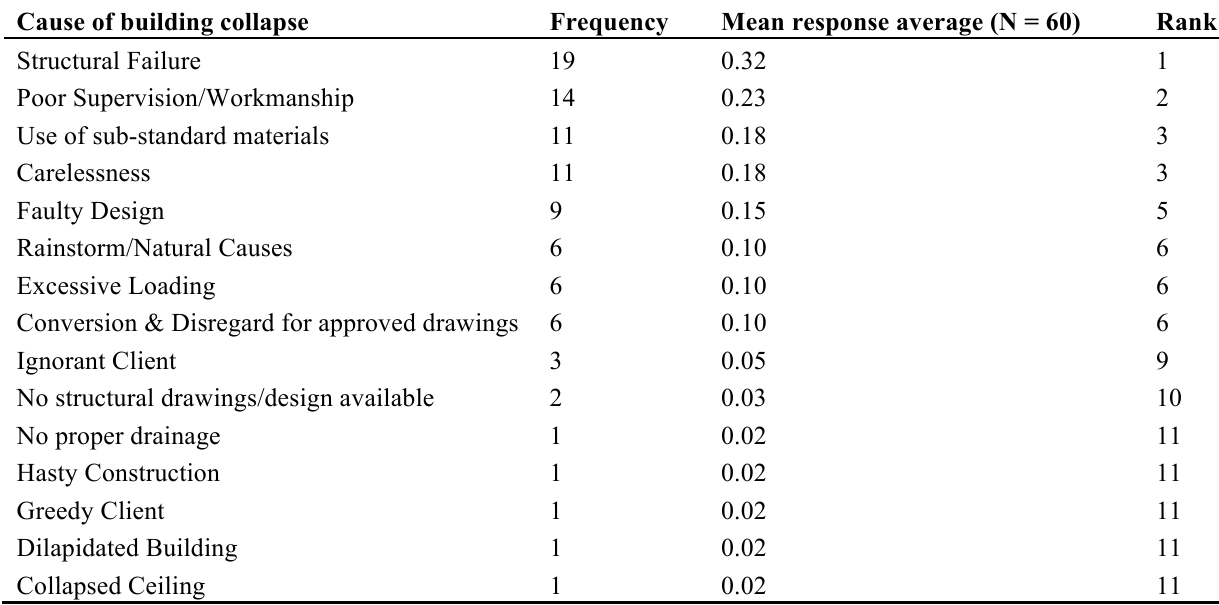
Table 2. Causes of building collapse